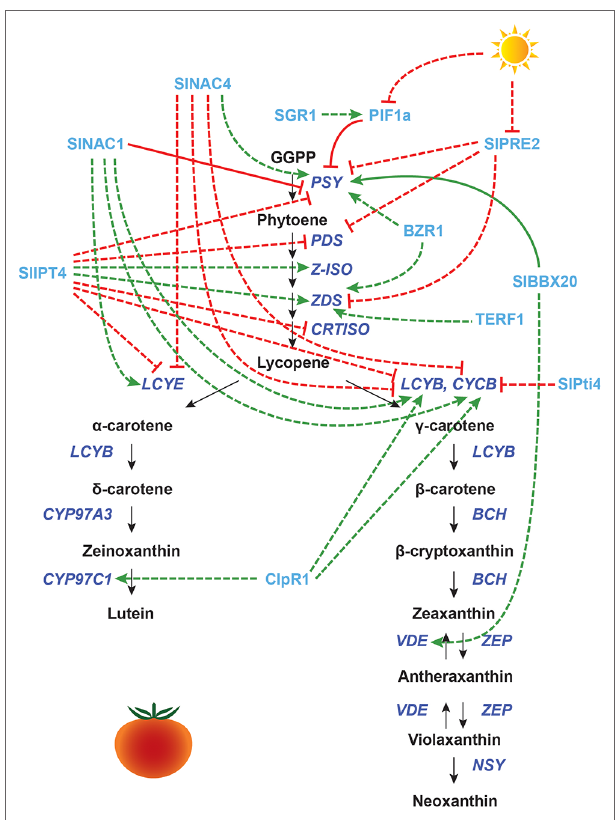
FIGURE 3 | Transcriptional regulation of CBP genes in tomato fruits: other proteins. The regulation of CBP genes in tomato fruits. The carotenoid biosynthesis pathway is shown in black, with carotenoid biosynthesis genes indicated in dark blue. Carotenoid regulators discussed in the paper are shown in light blue. Green arrows indicate positive regulation, while blunt red arrows indicate negative regulation. Solid lines show direct interactions, while dotted lines show indirect